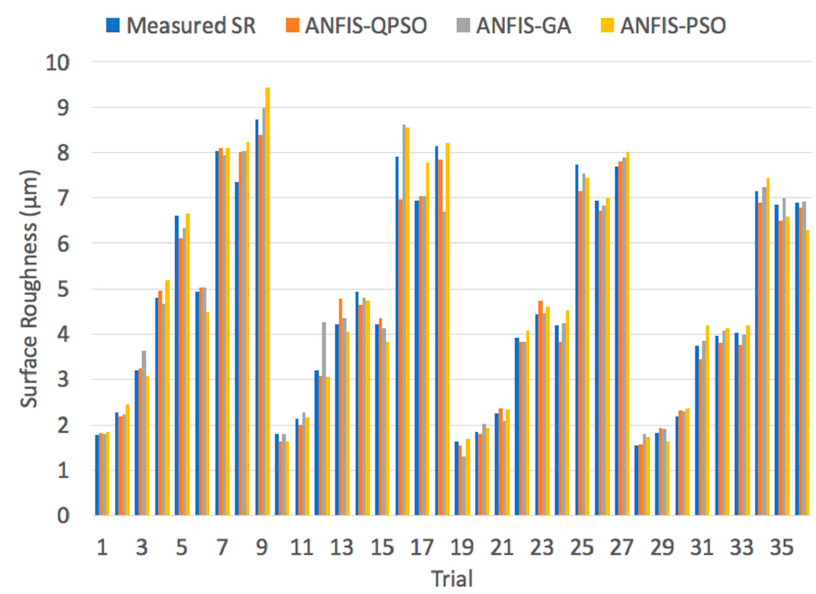
Figure 15. Measured surface roughness vs. predicted surface roughness values of a dry turning process